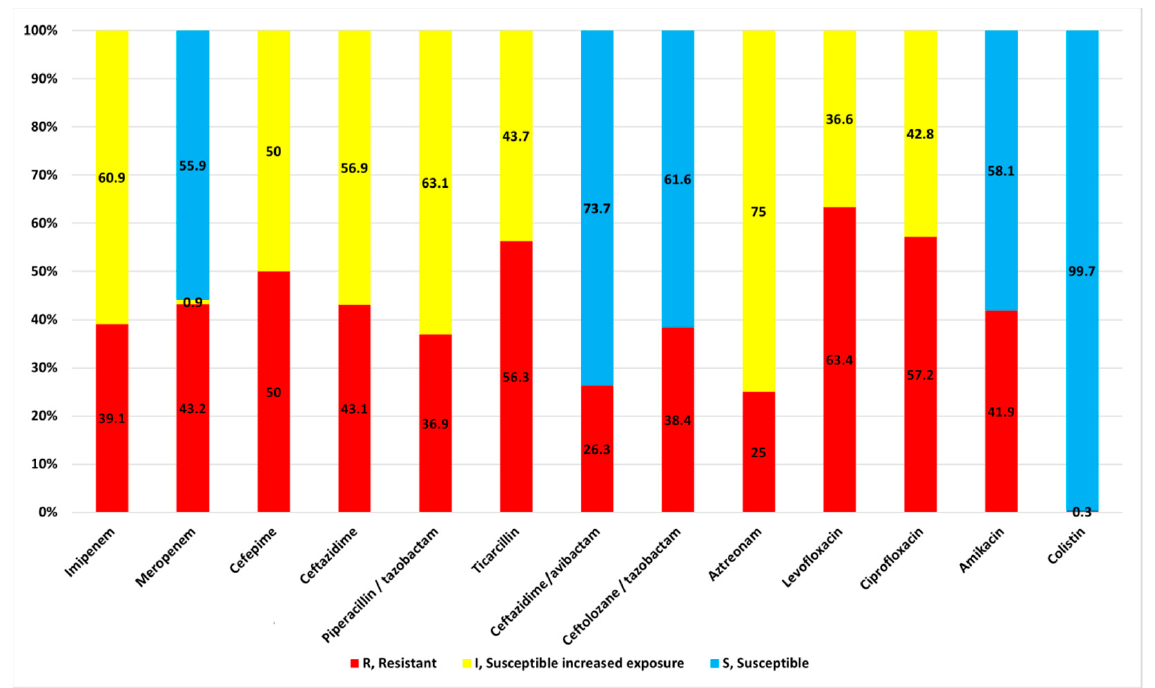
Figure 1. Antimicrobial resistance of the 320 clinical isolates of Pseudomonas aeruginosa.